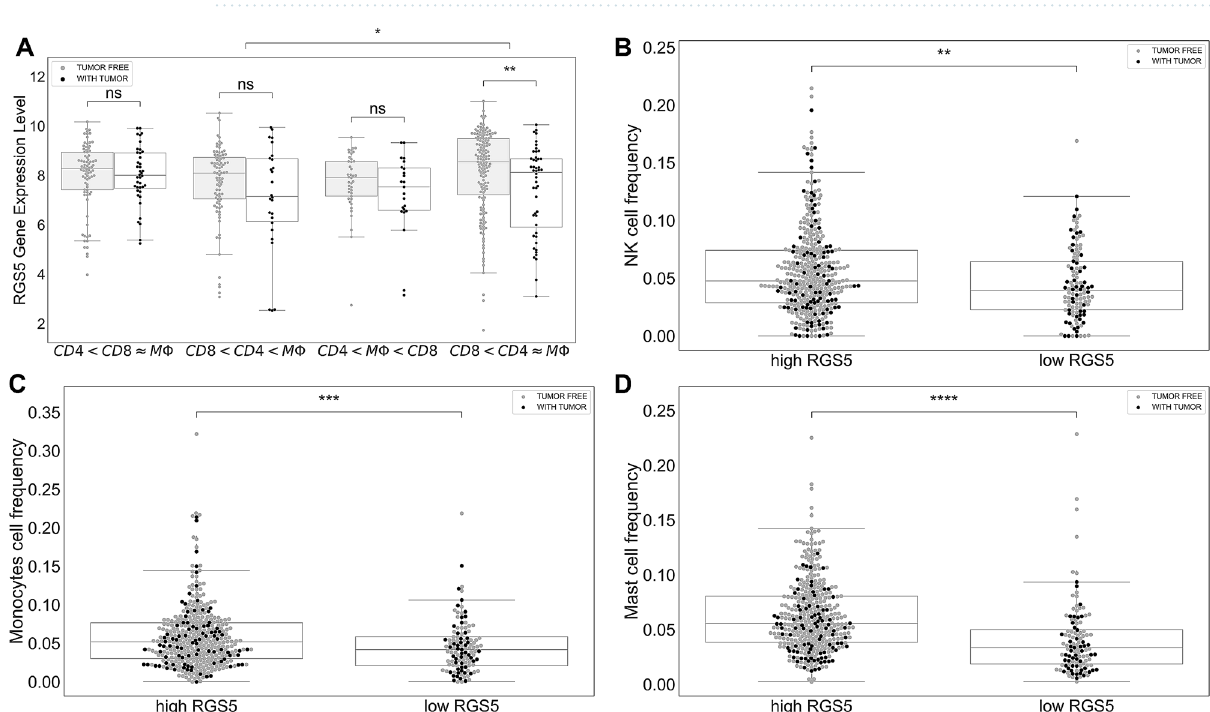
Figure 6. RGS5 expression level in ccRCC tumors. Sub-figure ( A ) shows the expression level of RGS5 in ccRCC tumors in each cluster as a function of tumor status. Sub-figures ( B ), ( C ) and ( D ) indicate the relation between the level of RGS5 and the percentages of NK cells, monocytes, and mast cells in ccRCC tumors,